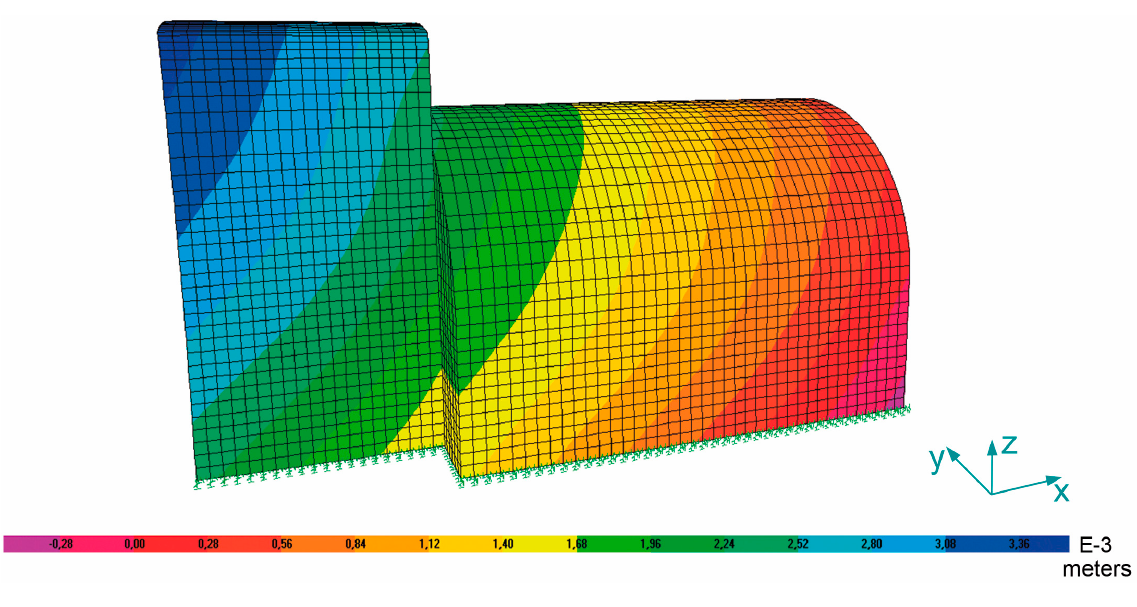
Figure 13. The deformation of the cellar (×200) along the Y-axis of the global model and in the SLS1